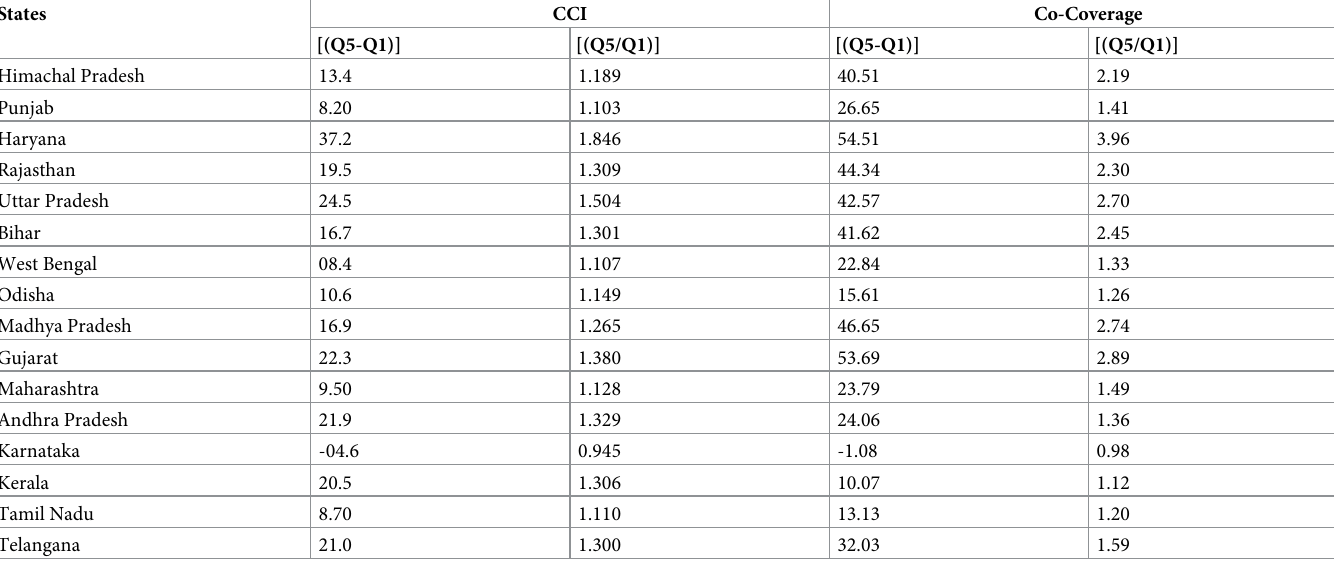
Table 2. Absolute and relative differences in the coverage CCI and Co-Cov indicators across major Indian states.